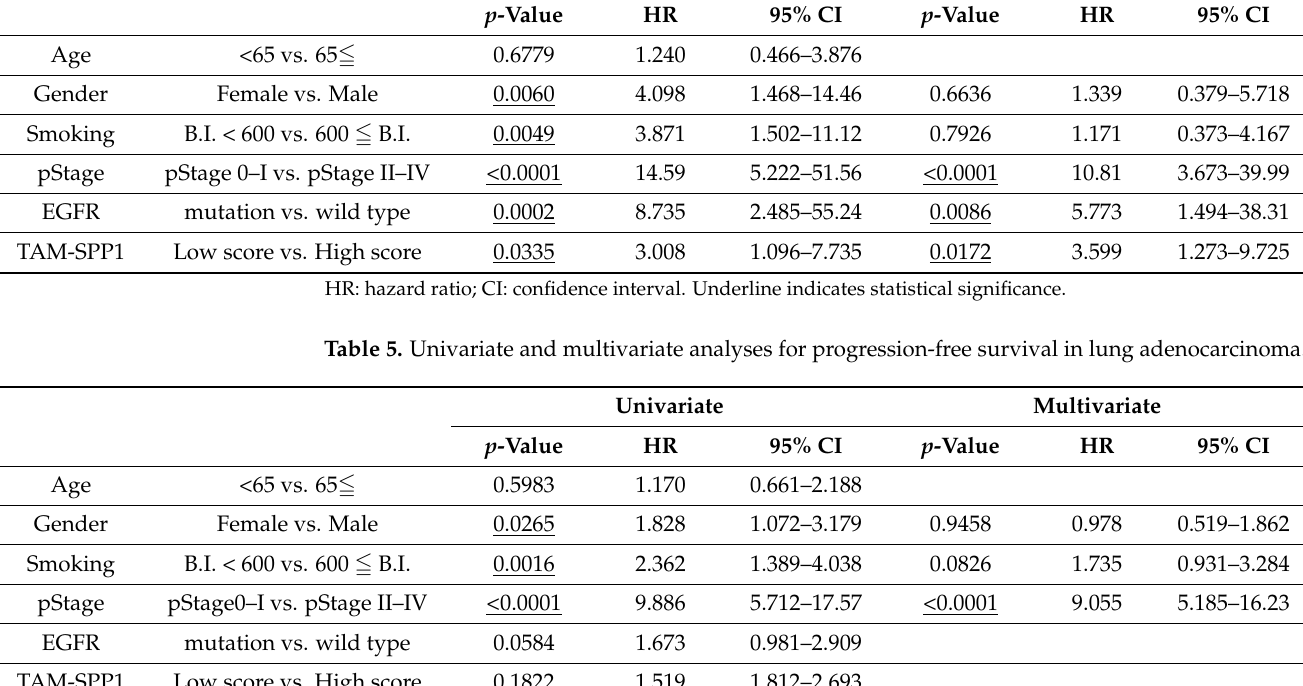
Table 4. Univariate and multivariate analyses for cancer-specific survival in lung adenocarcinoma. Univariate Multivariate